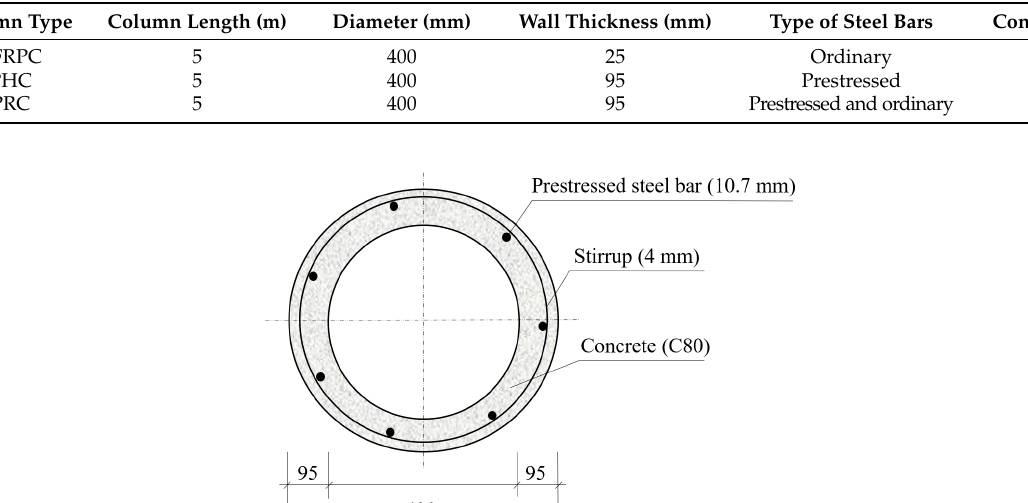
Table 1. Basic parameters of the CBF material. Table 2. Basic parameters of column specimens.